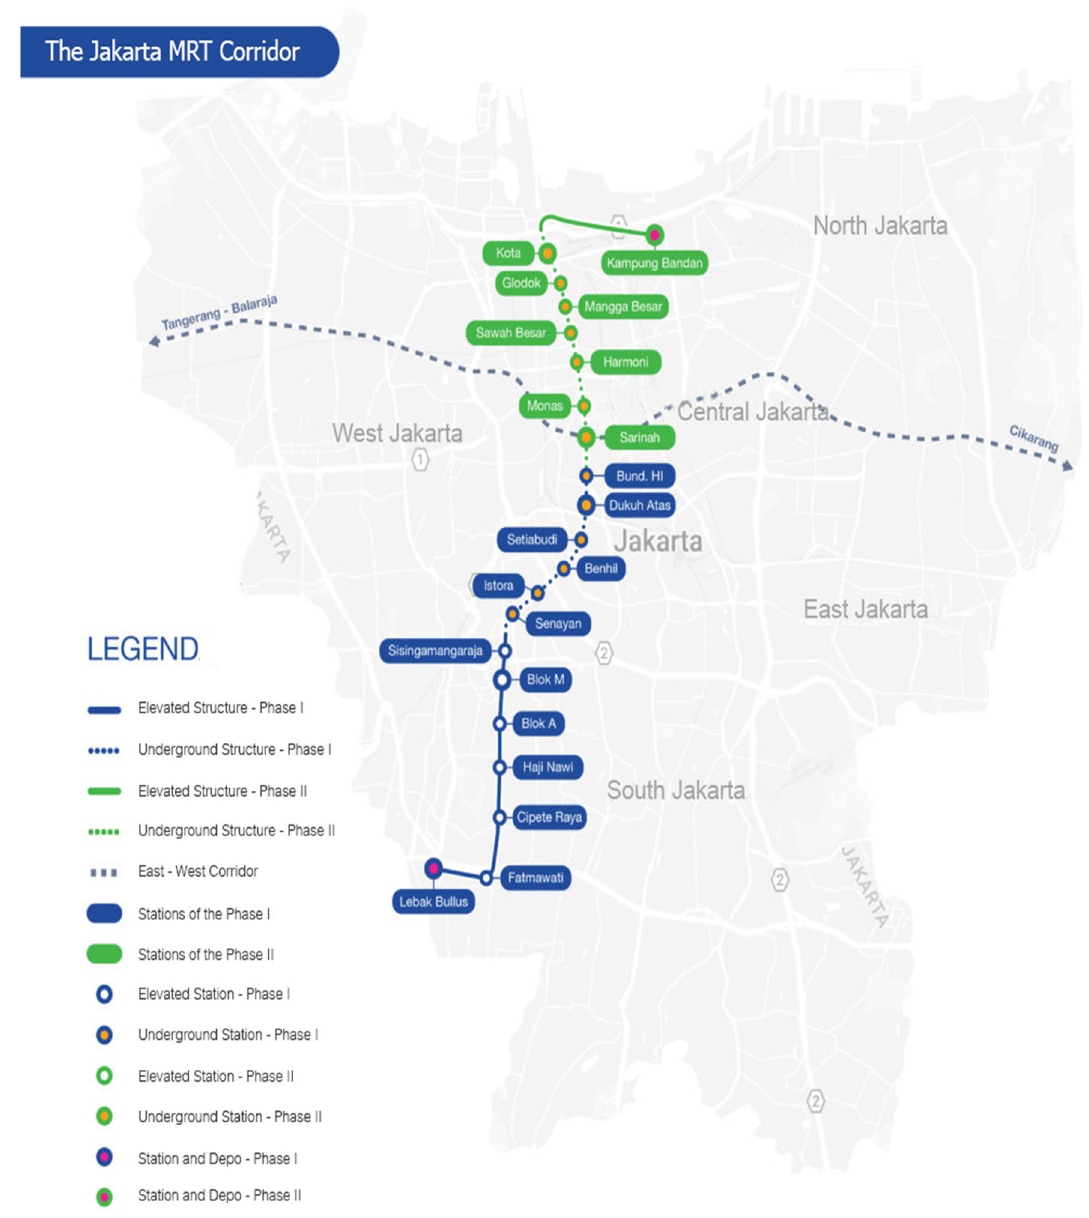
Fig. 1 Jakarta MRT’s corridor (edited from PT. MRT Jakarta